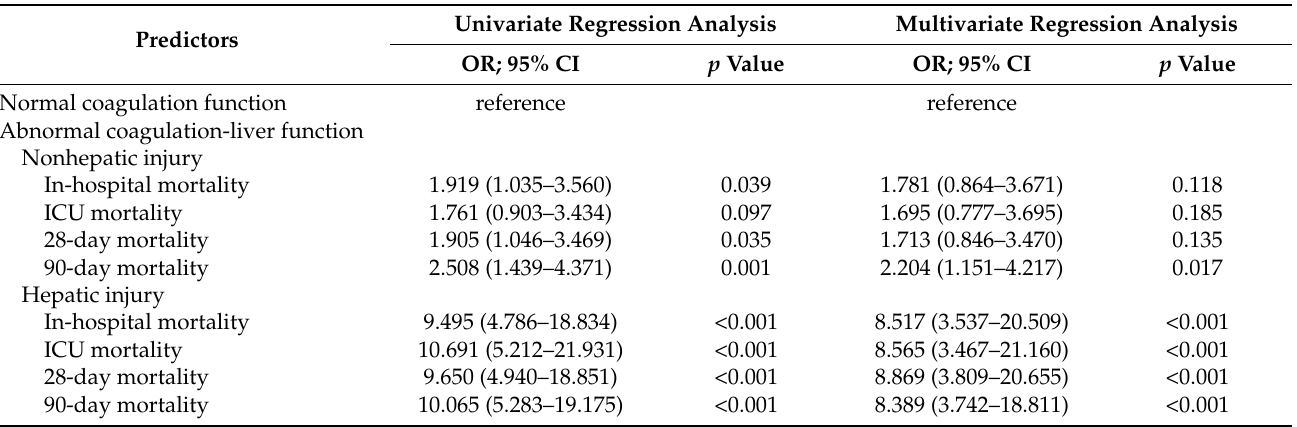
Table 4. The joint effects of acute hepatic injury and coagulation disorder on mortality. Univariate Regression Analysis Multivariate Regression Predictors